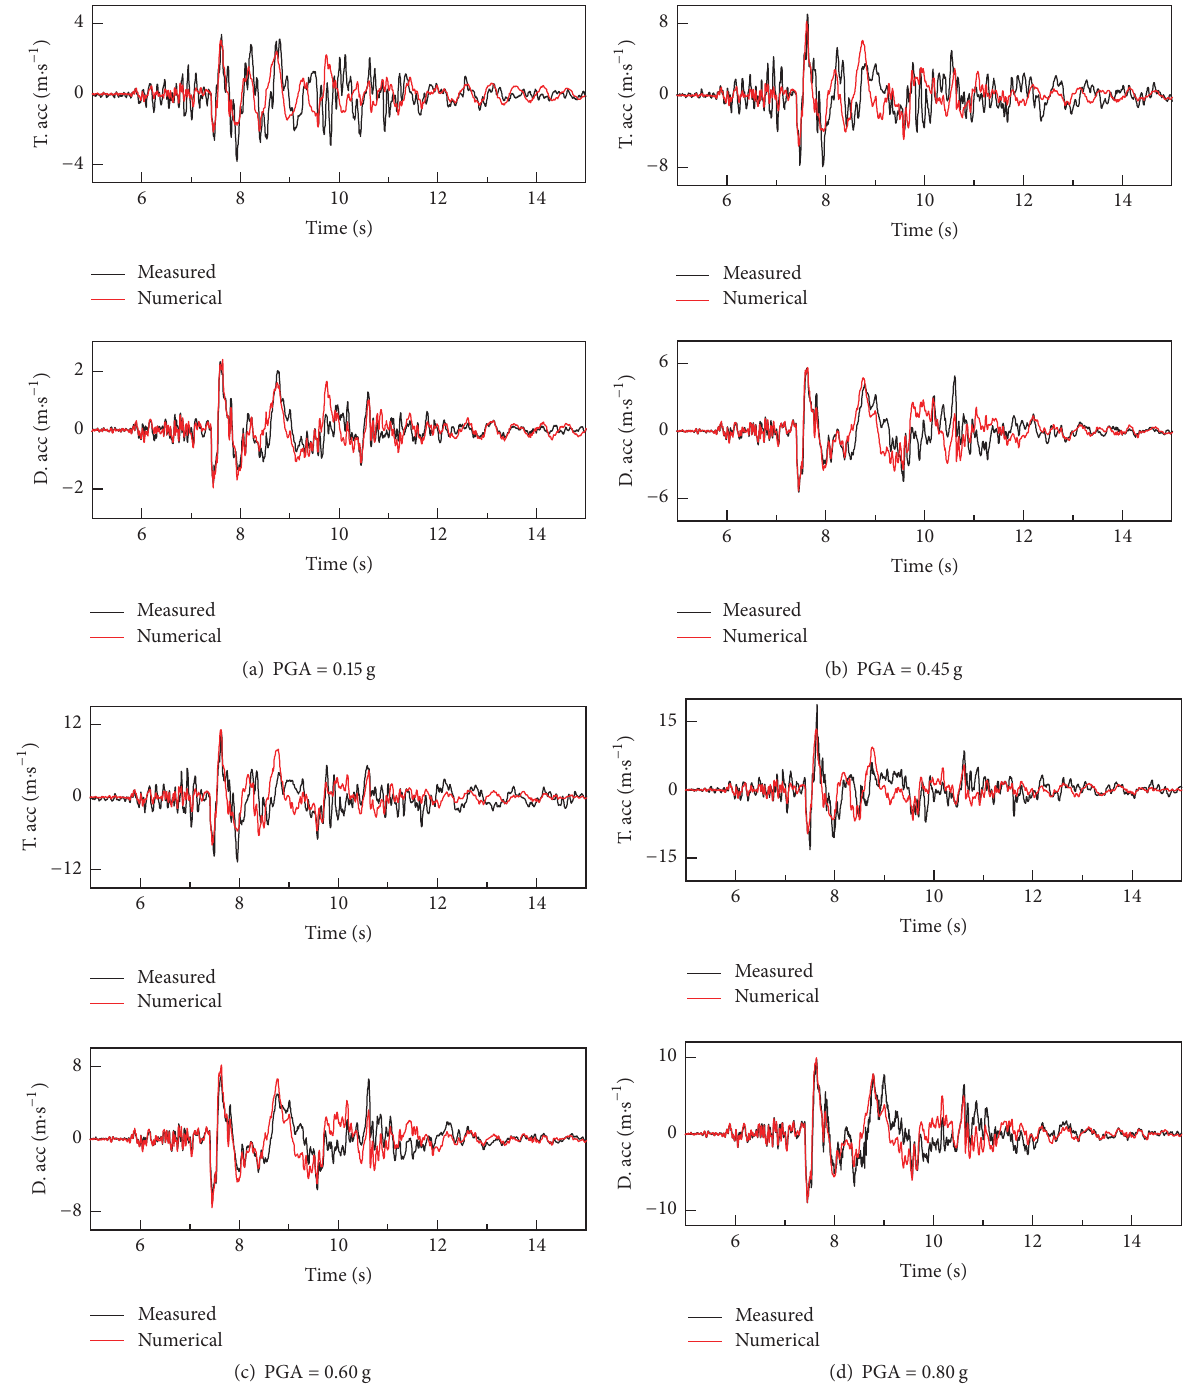
Figure 13: Comparisons between measured and numerical results of acceleration histories at tower top and deck end.